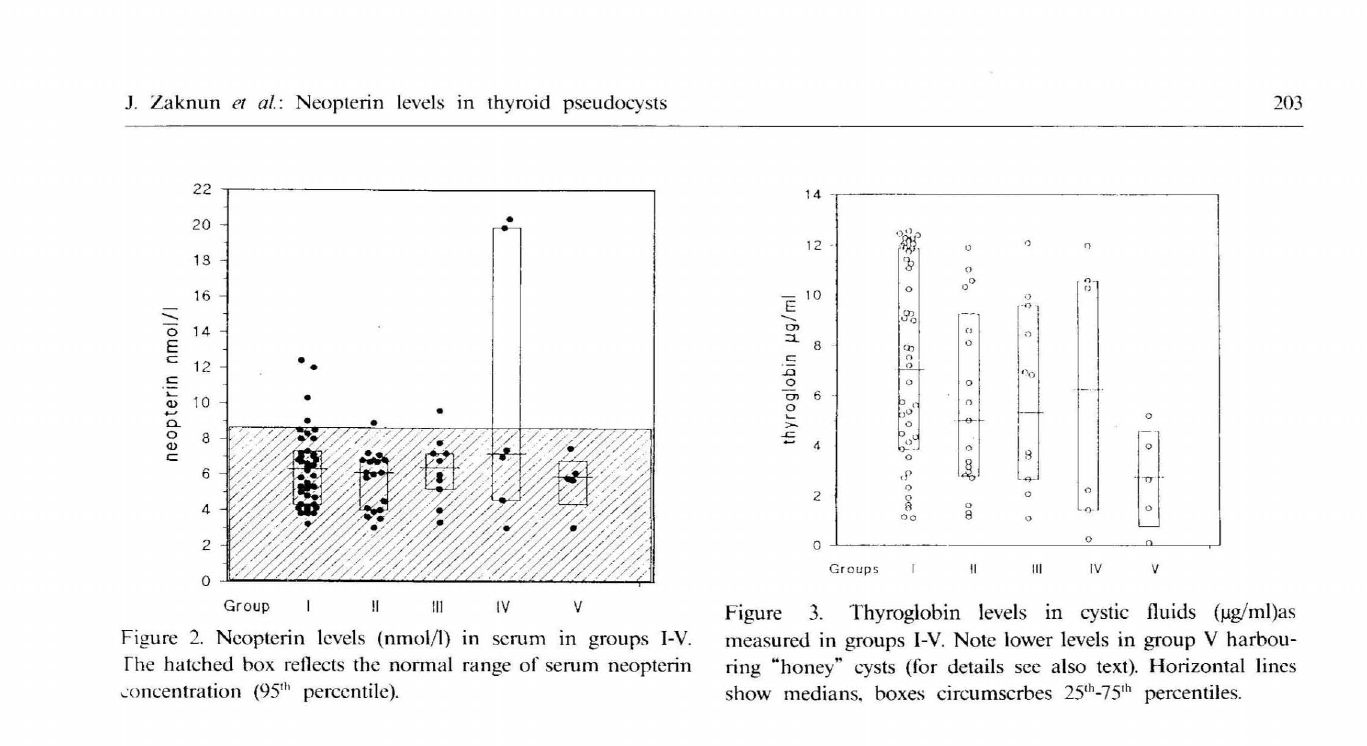
Figure 2. Neopterin levels (nmol/l) In serum in groups I-V. fhe hatched box reflects the nonnal range of serum neopterin c:oncentration (95 1h percentile).